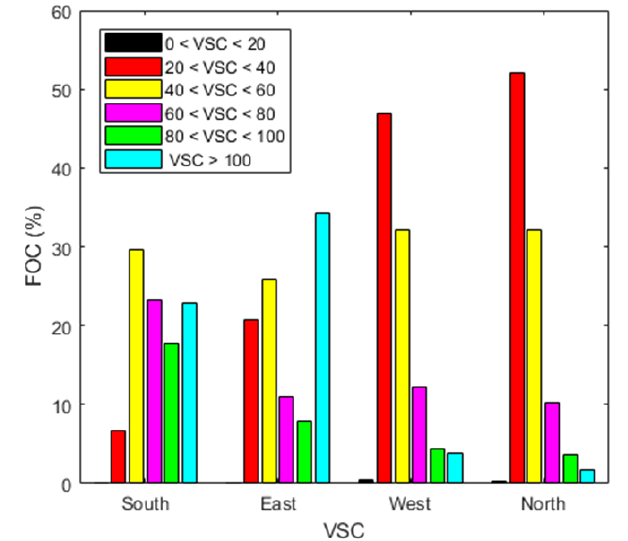
Figure 6. Distribution of VSC values by intervals calculated in Burgos, Spain, between September 2016 and January 2019.